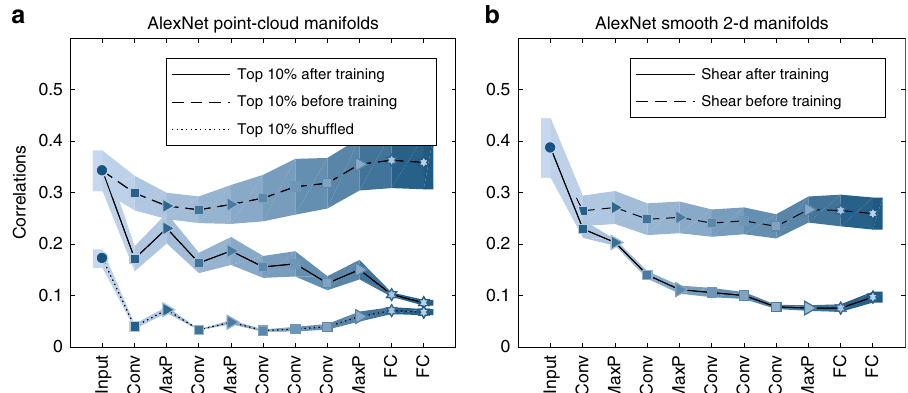
Fig. 7 Correlations between manifolds. Changes of mean between-manifold correlations along the layers of AlexNet. a Center correlations for top 10% point-cloud manifolds in fully trained network (full line), randomly initialized network (dashed line) or randomly shuf fl ed object manifolds (dotted line). b Center correlations for smooth 2-d shear manifolds in fully trained network (full line) or randomly initialized network (dashed line). Line and markers indicate mean value over different choices of objects; surrounding shaded areas indicate 95% con fi dence interval. The x -axis labels provides abbreviation of the layer types. Marker shape represents layer type (circle — pixel layer, square — convolution layer, right-triangle — max-pooling layer, hexagon — fully connected layer). Features in linear layers are extracted after a ReLU nonlinearity. Color changes from dark to light along the network. Center